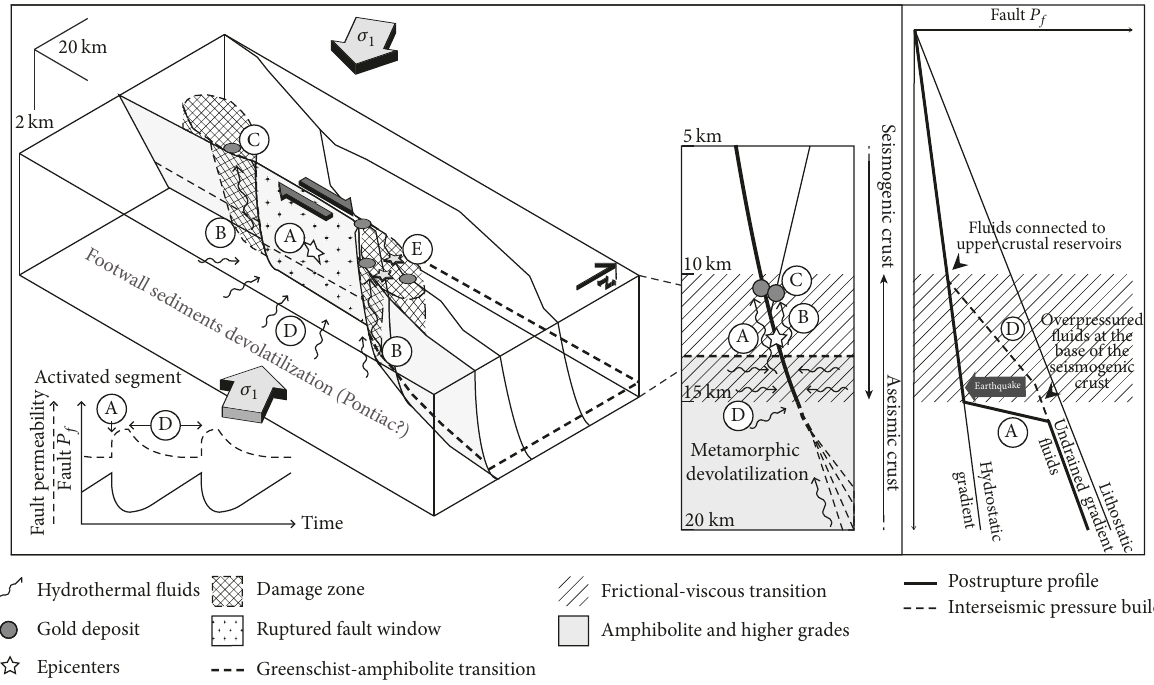
Figure 9: Schematic model and sections of the active Cadillac-Larder Lake Fault showing relationships between fault activation, seismicity, and fluid flow following failure on the Joannes Segment. (a) Seismic rupture along the active segment generates an increase in fault permeability and a drop in fluid pressure. (b) Upward fluid migration along damage zones. (c) Gold precipitation and iterative deposit formation over time. (d) Fault permeability closure, pervasive migration of metamorphic and/or magmatic fluids, and pressure build-up at the base of the seismogenic crust. (e) Doublet aftershock along secondary faults located in the main damage zone.